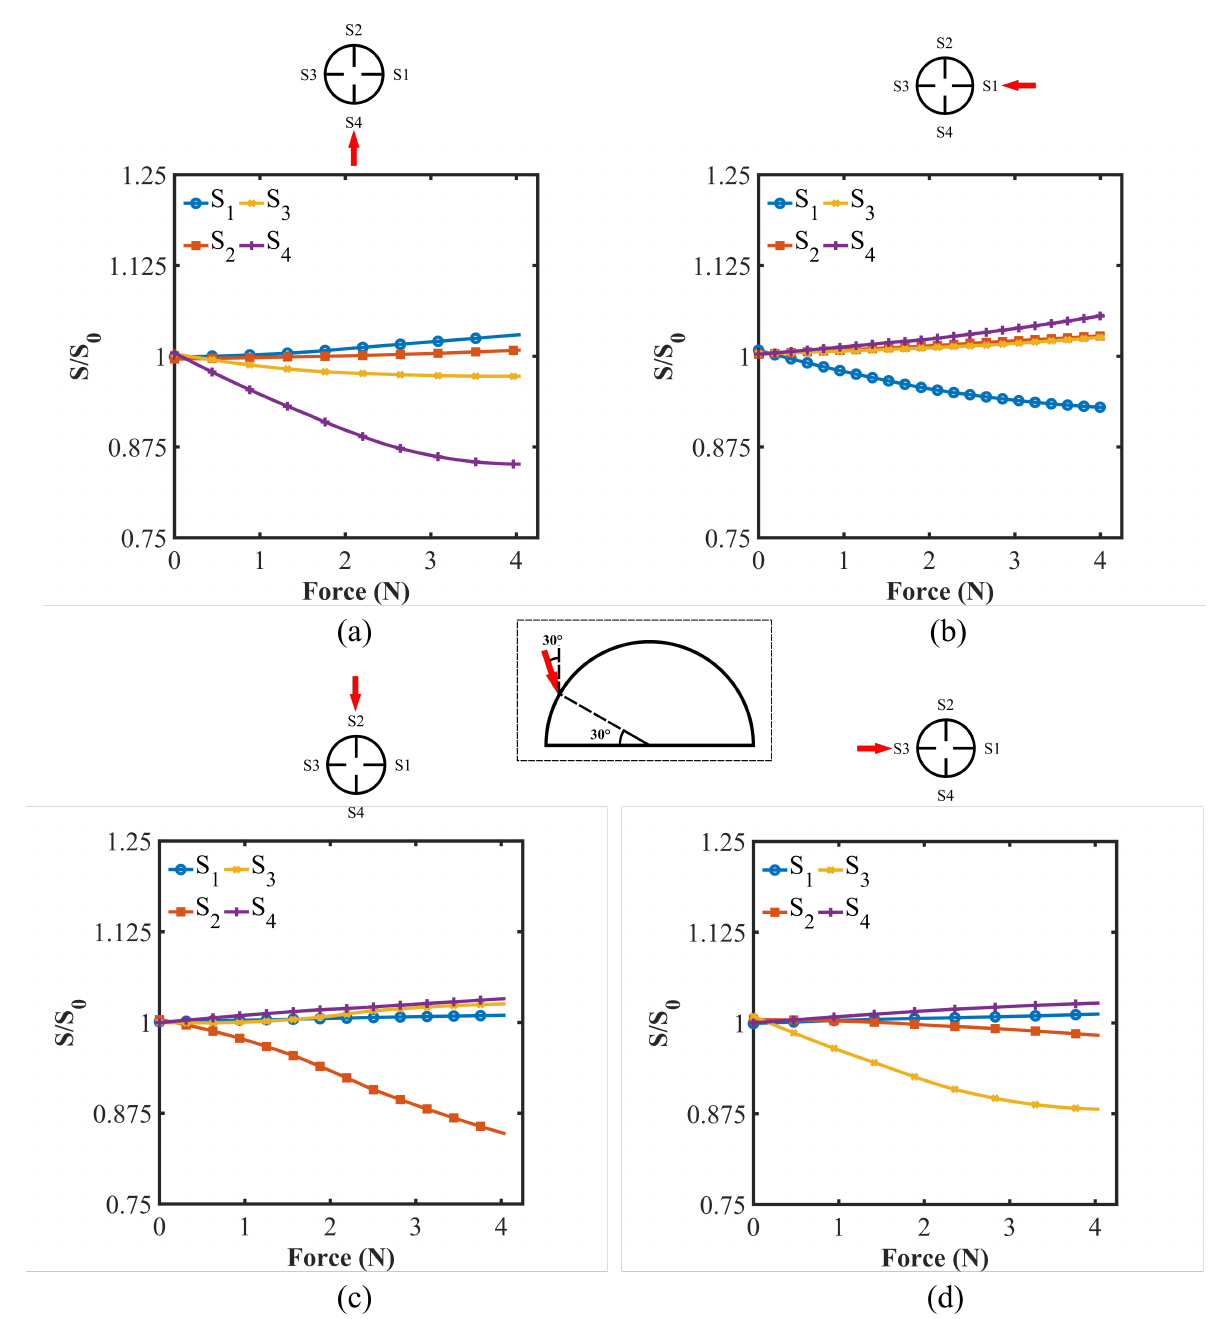
Figure 8. Readouts of the sensor for applied forces along 30 ◦ with vertical axis, on the sides of the hemispherical sensor at 30 ◦ latitude (exactly on the ( a ) S 4 , ( b ) S 1 , ( c ) S 2 , and ( d ) S 3 flex sensors); top view of the sensor array is demonstrated and the red arrow depicts the applied force